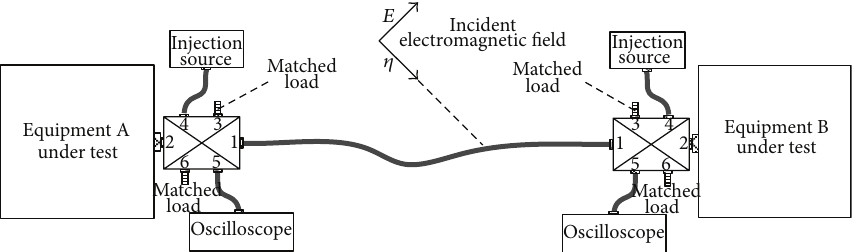
Figure 10: The typical test configuration of DDMCI test